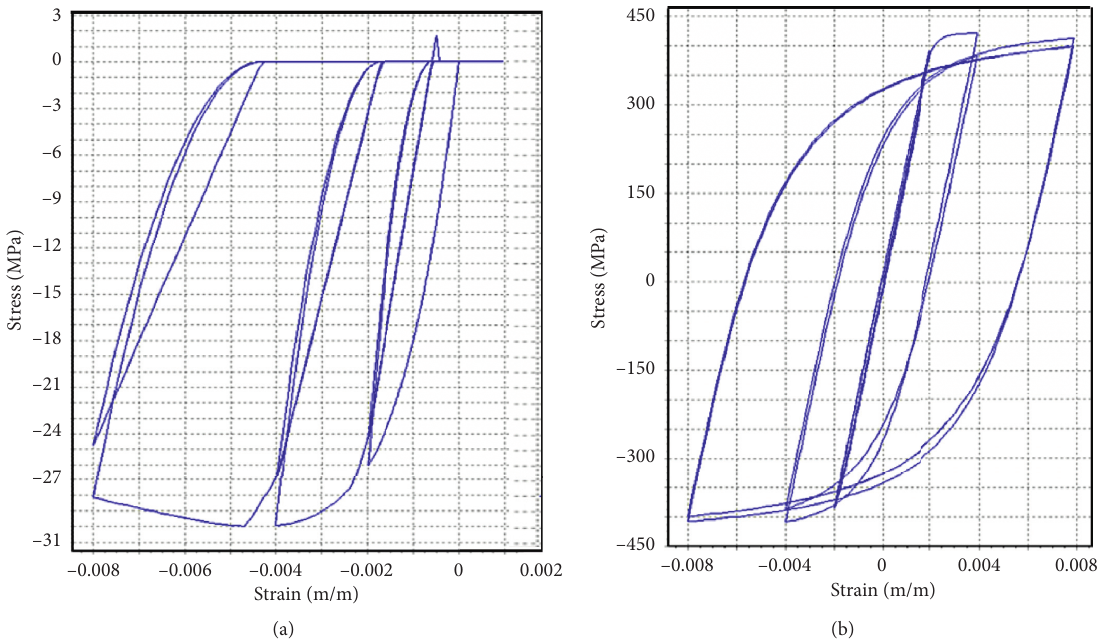
Figure 4: Constitutive models used in the nonlinear numerical model: (a) concrete and (b) reinforcing steel.